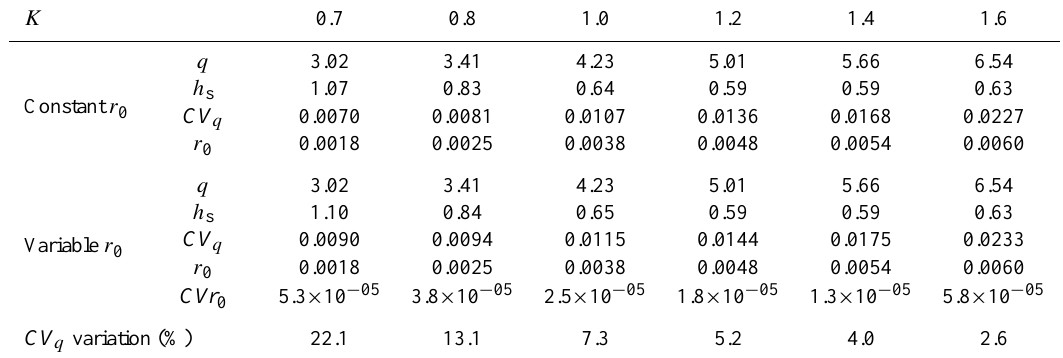
Table 5. Results of simulations in an SDI unit, with an inlet pressure of 20 m, in different soils and for different emitter discharges. K